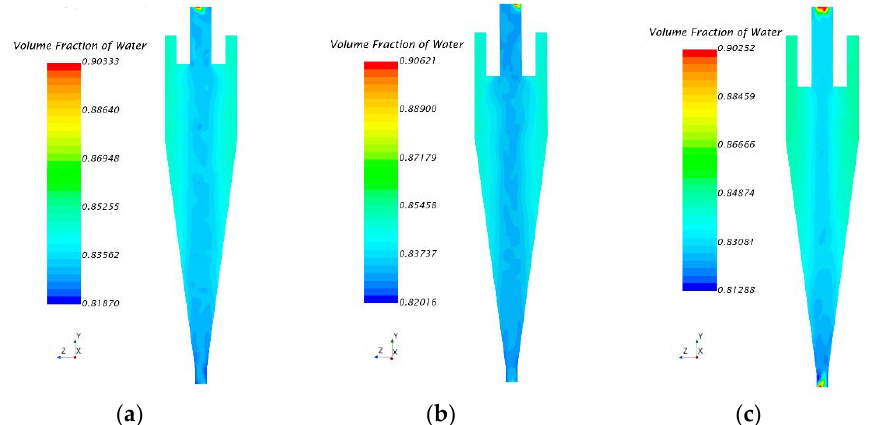
Figure 4. Volume fraction of water at 60 s at an inlet feed velocity of 3 m/s ( a ) VF = 20 mm ( b ) VF = 30 mm ( c ) VF = 35 mm.